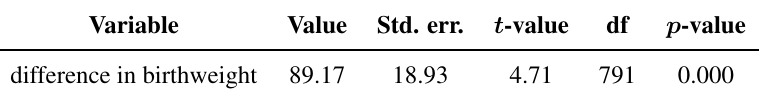
Table 4. Paired t -test for the comparison between